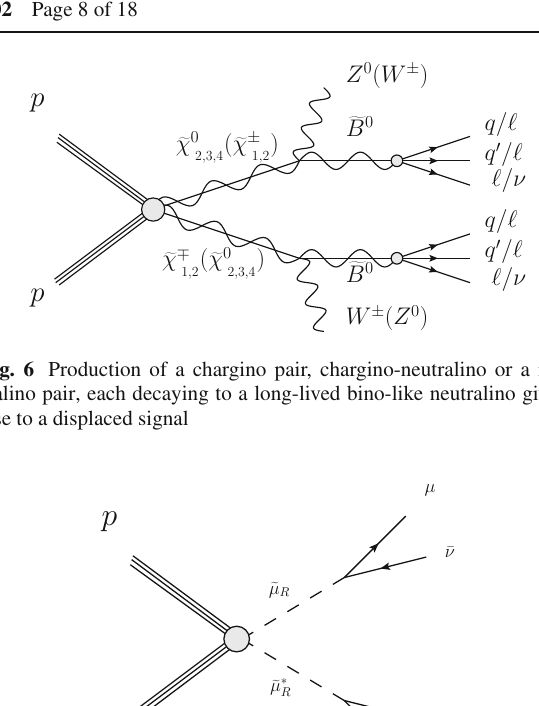
Fig. 4, but without the presence of neutrinos coming from